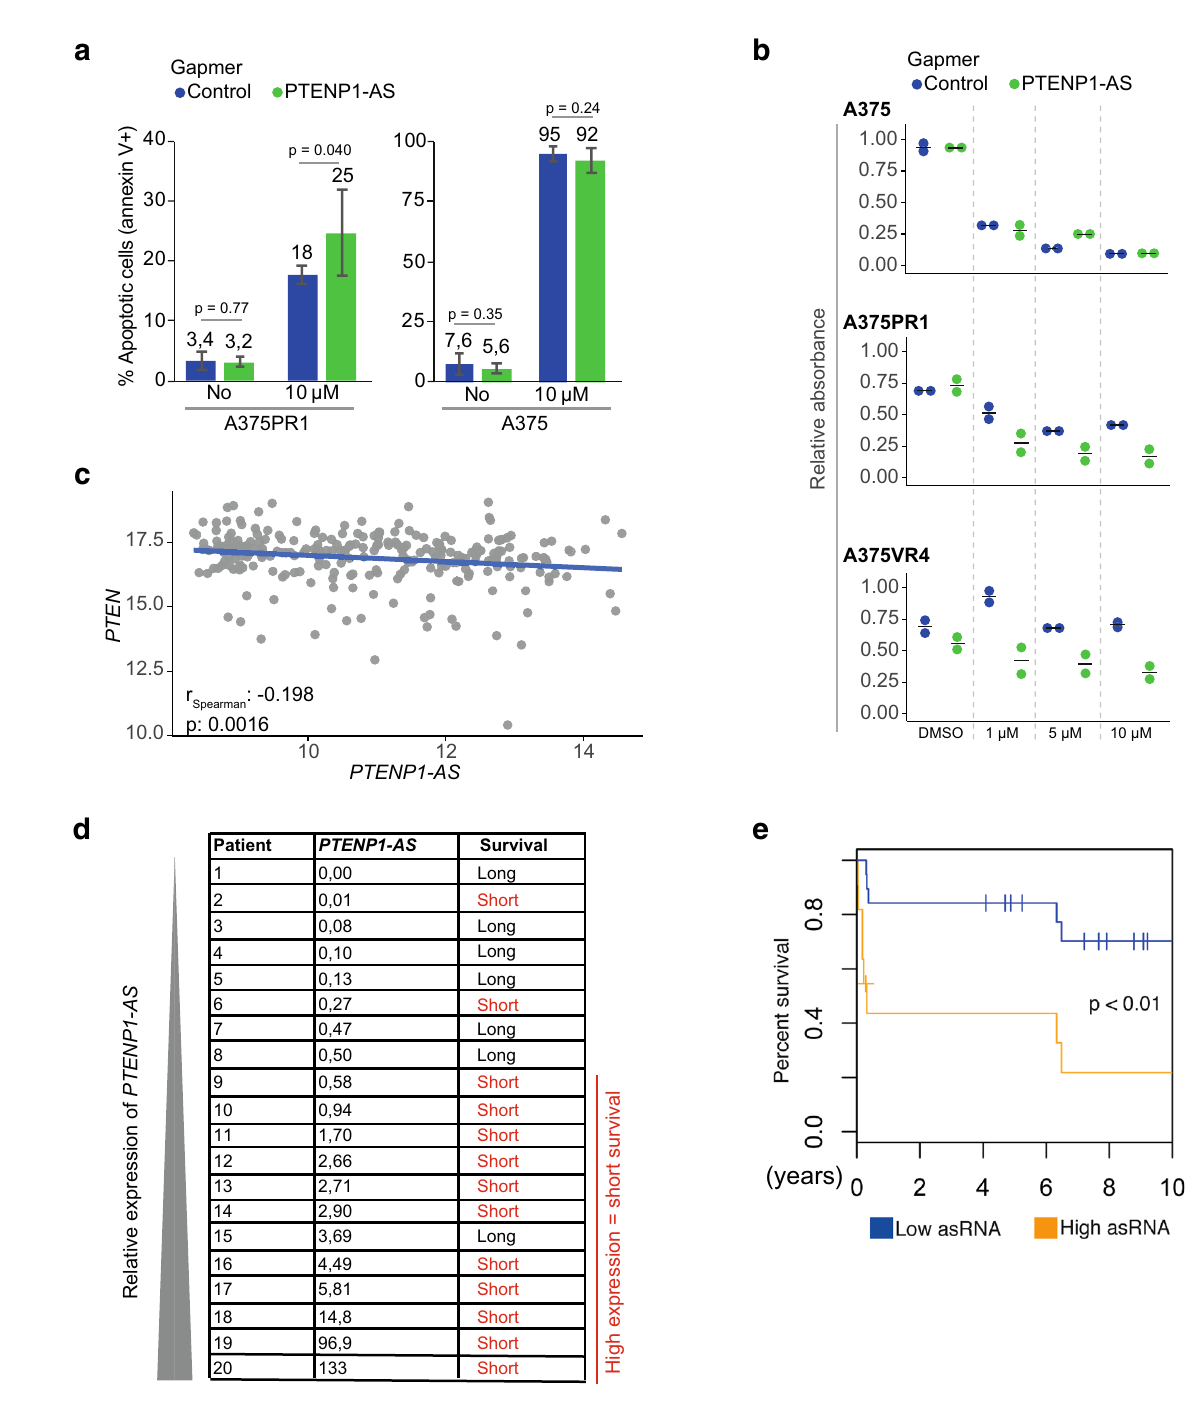
Figure 5. Manipulation of PTENP1-AS in BRAFi resistant sublines and evaluation of PTENP1-AS in metastatic melanoma samples. ( a ) Cell-death analysis by annexin V and propidium iodide staining upon knockdown of PTENP1-AS and vemurafenib treatment (n = 6). ( b ) Colony formation assays for A375, A375PR1 and A375VR4 cell lines measuring relative absorbance of crystal violet solution stained colonies upon gapmer ASO-induced knockdown of PTENP1-AS co-treated with various concentrations of vemurafenib. ( c ) Expression data (TCGA) for PTEN and PTENP1-AS from melanoma samples. ( d ) qRTPCR measuring expression levels of PTENP1-AS in a set of 20 first regional lymph node metastases from stage III melanoma patients. Based on clinical follow up data, the patients were categorized as long- or short-term survivors, > 60 months or ≤ 13 months, respectively. ( e ) Kaplan– Meier plot showing overall survival for patients with high (n = 12) or low (n = 17) expression levels of PTENP1-AS . Expression levels of PTENP1-AS was measured in first regional lymph node metastases from an independent set of 29 stage III melanoma patients using qRTPCR. The p-value represents a log-rank